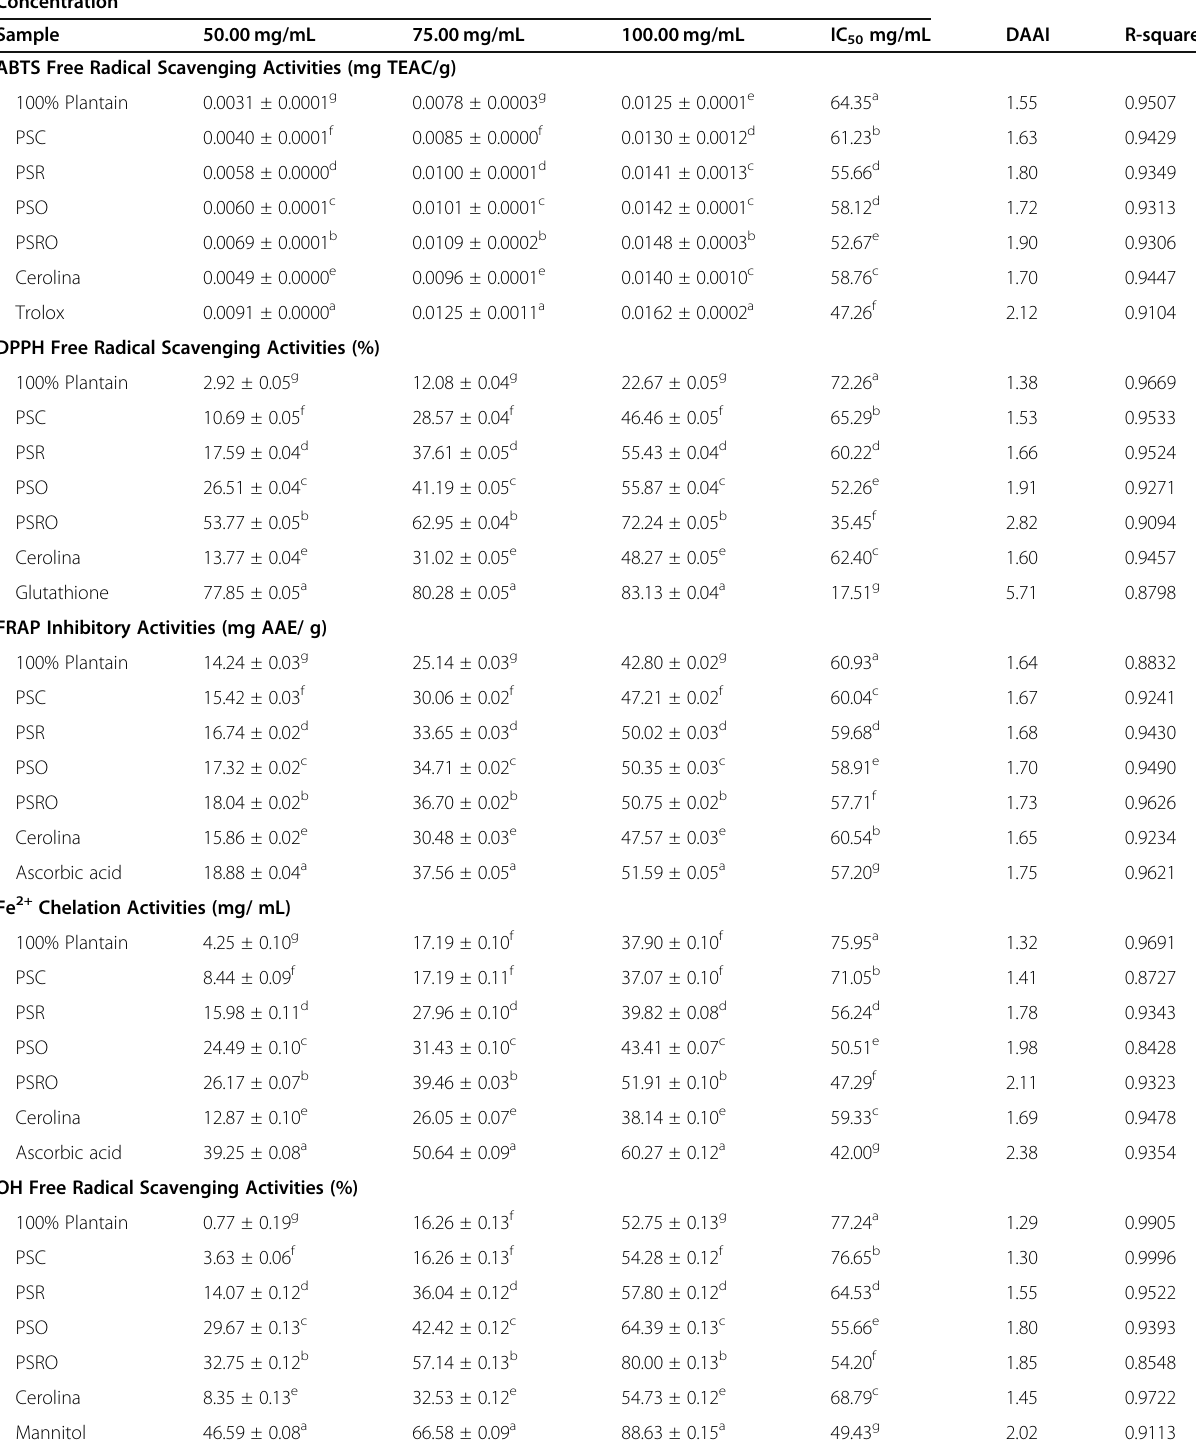
Table 7 Antioxidant activities of plantain, soycake, rice-bran and oat-bran flour and control samples